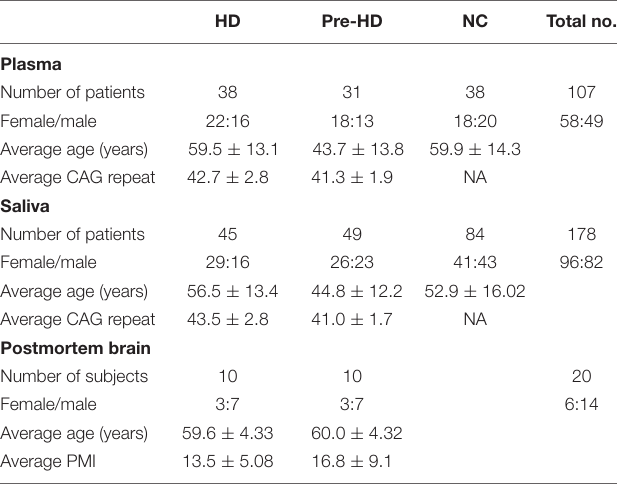
TABLE 1 | Summary of subjects used for these